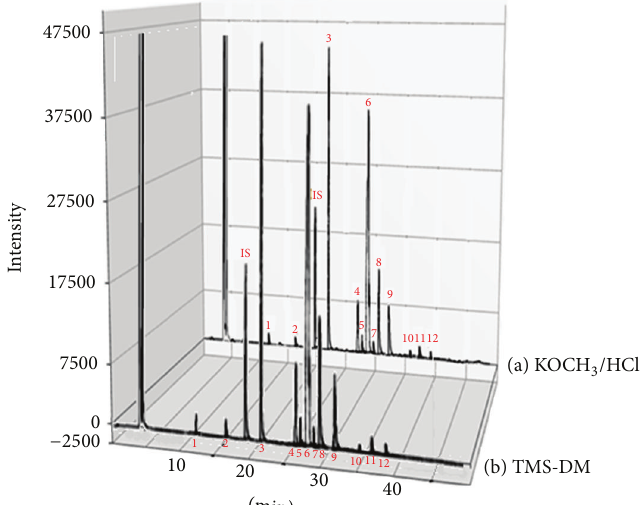
Figure 2: GC-FID chromatograms of the total FAs for a sample of bakery products (biscuit) derivatized by the KOCH 3 /HCl method (a) and TMS-DM method (b) 1 = C12:0; 2 = C14:0; 3 = C16:0; 4 = C18:0; 5 = C18:1 t9; 6 = C18:1; 7 = 18:2 9t,12t; 8 = C18:2; 9 = C18:3; 10 = C20:0; 11 = C22:0, 12 = C24:0, IS =